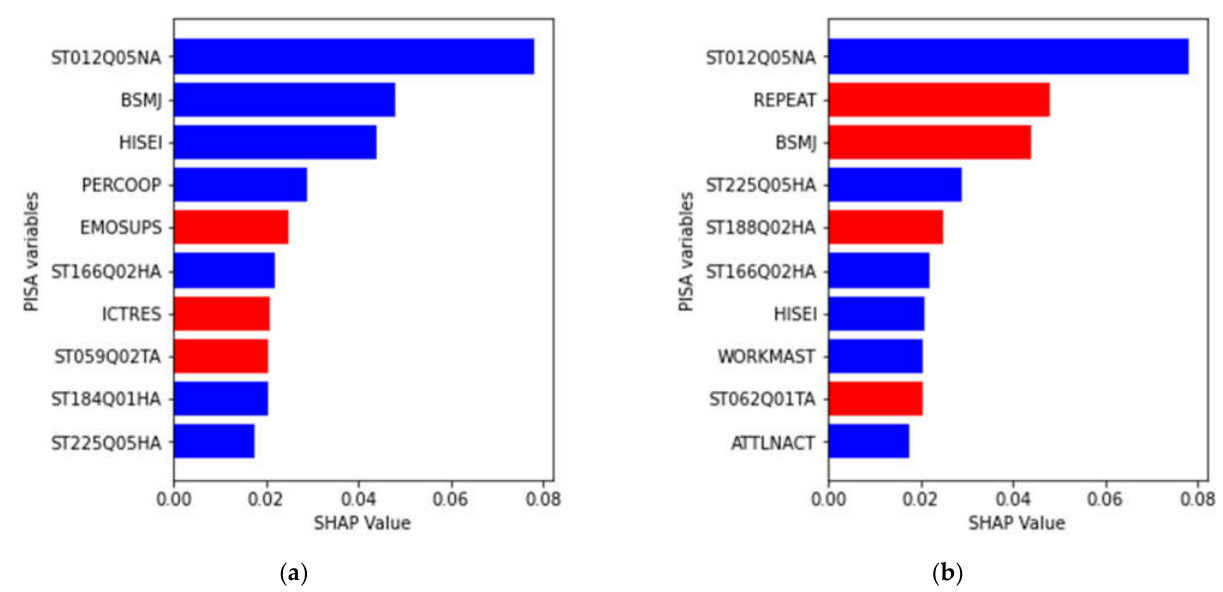
Figure 3. Top 10 most significant variables (in descending order) in the Random Forest model classifier for ( a ) private school participants and ( b ) public school participants. Red bars represent direct relationships with identifying the poor performing students while blue bars represent inverse relationships with identifying poor performing students. SHAP values represent the level of variable importance relative to other variables.